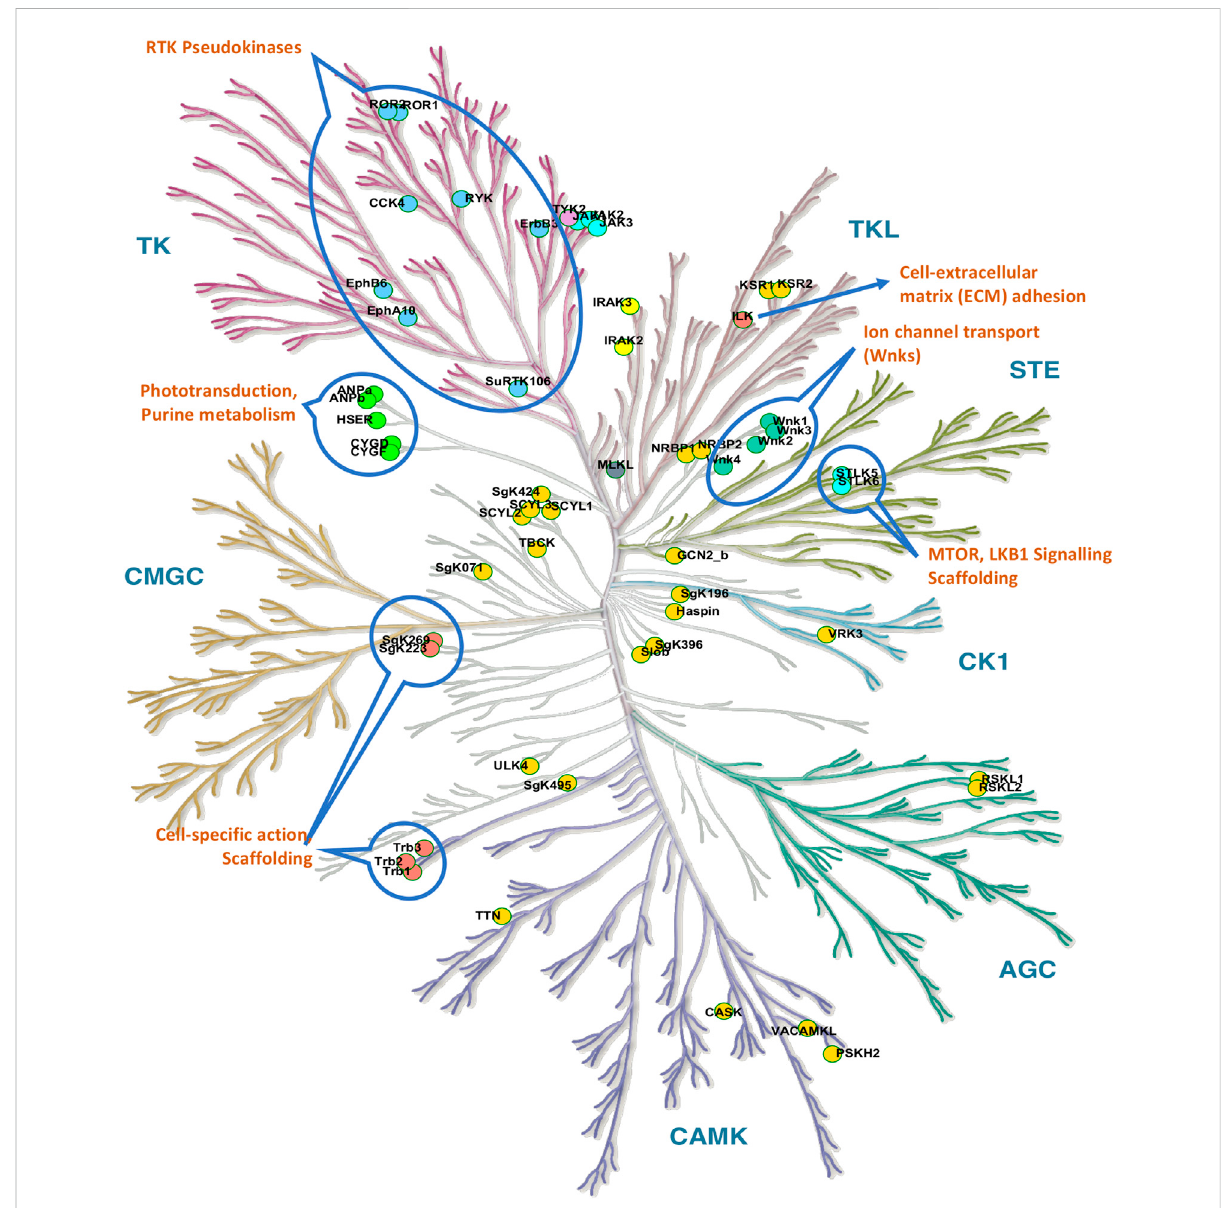
FIGURE 2 Visualizationofpseudokinases.Thekinometreeofpseudokinasesshowsarangeoffunctionsincludingscaffolding(TheTribblesTRIB1-3),cell- speci fi c actions, visual signal transduction (phototransduction), purine metabolism, Ephrin receptors, ion channel transport (Wnk1-4), and others. ThepseudokinasesADCK3(atypical)andPAN3(other)arenotshown.ThekinometreeillustrationisreproducedfromKinmapportalbyCellSignaling Technology,